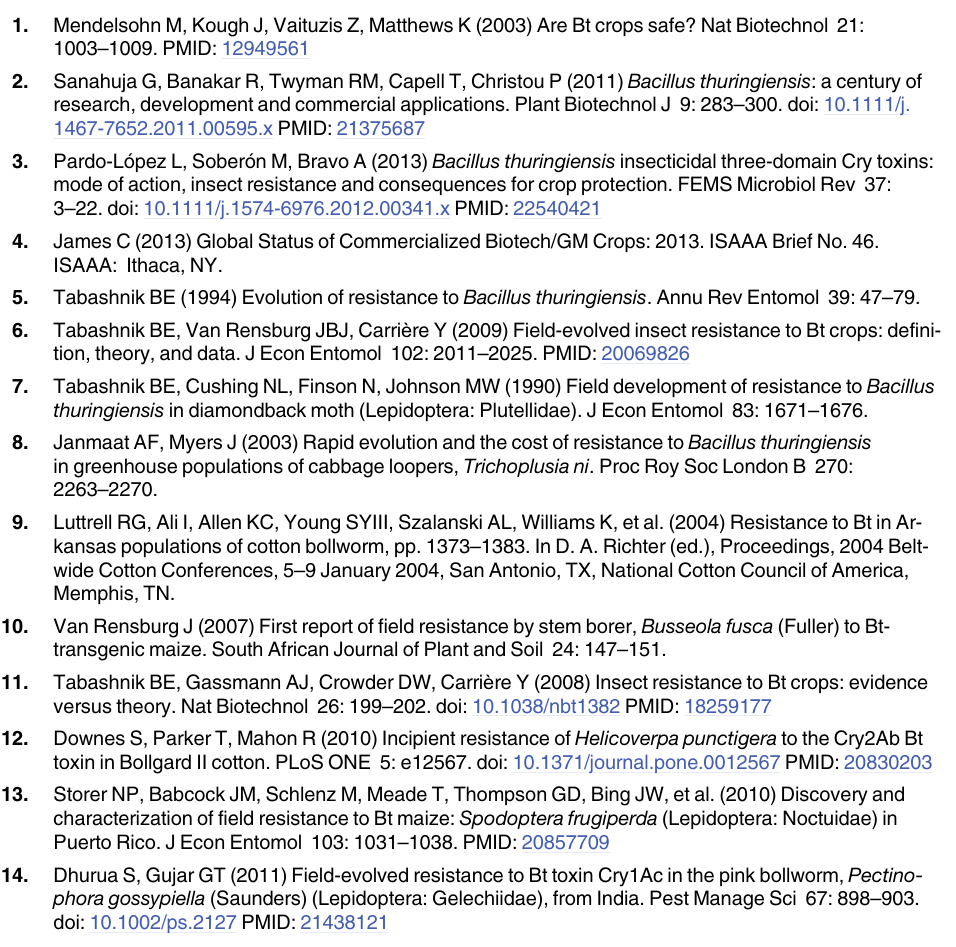
S4 Table. Data for Fig 7 Synergism of Cry1Ac by HaALP1f vs. susceptible & resistant strains. S5 Table. Data for Fig 8 Synergism of Cry1Ac by HaALP1f vs. susceptible strain. (XLSX) S6 Table. Data for enrichment of APN activity in